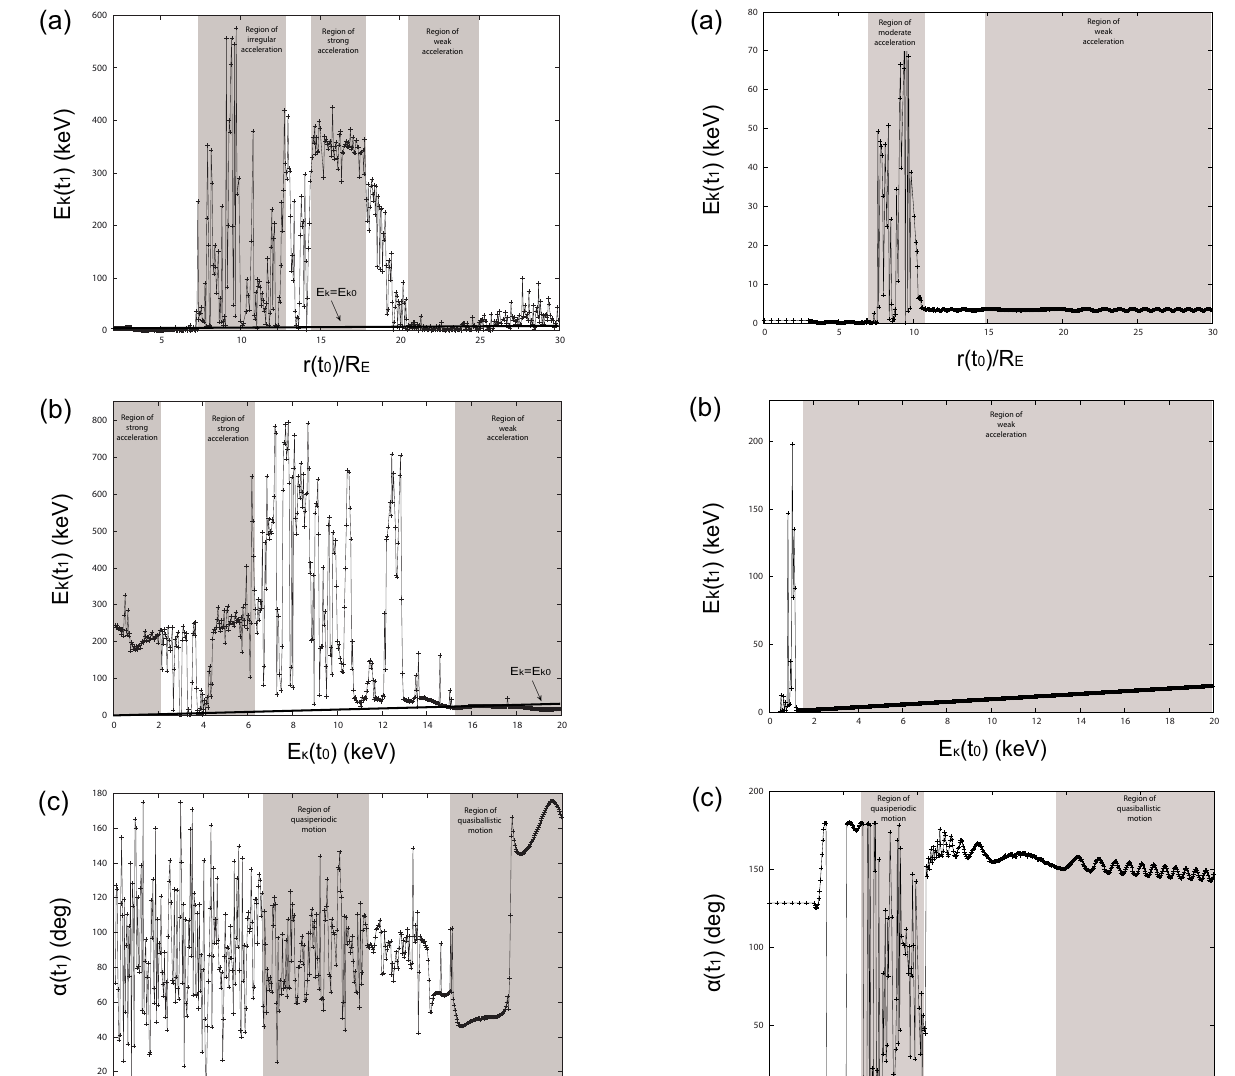
injected from the plasma sheet with random initial conditions for r(t 0 ) within [18 R E , 22 R E ], for E k (t 0 ) within [2 , 6] keV and for θ(t 0 ) within [20 , 30] ◦ , and all the other input being the same as above. One should notice that the conclusions drawn from Figs. 9 and 10, on the basis of single-particle dynamics, are verified. We highlight that, according to the computations, 46 % of the O + ions of the ensemble are in- corporated into the ring current, in contrast to nearly 4 % of the H + ions, whereas a little more than 20 % in both